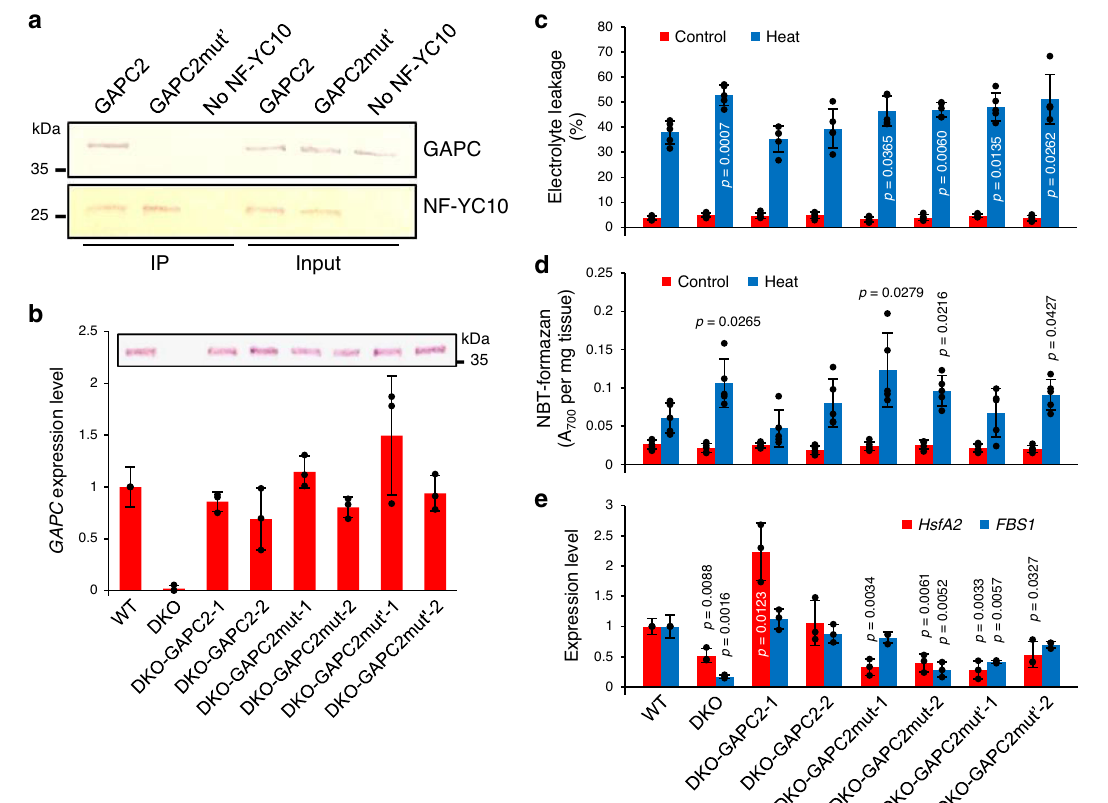
Fig. 8 Heat response of gapc1gapc2 (DKO) complemented with GAPC2 variants. a Co-immunoprecipitation of GAPC and NF-YC10. Puri fi ed GAPC2-6xHis or GAPC2mut ’ -6xHis was mixed with NF-YC10-6xHis-STREP. Immunoprecipitation (IP) was performed using an anti-STREP antibody, then immunoblotting was performed using an anti-6xHis antibody. Protein input is shown on the right. b GAPC expression levels. Total RNA was extracted from 10-day-old seedlings and quantitative RT-PCR was performed with GAPC2 -speci fi c primers. Values are average±S.D. from 3 independent seedlings and shown as fold change to WT. Black dots represent individual data points. DKO, double knockout mutant of GAPC . Inset, immunoblotting of GAPC. Total proteins were extracted from 5-day- old seedlings and GAPC was probed with the anti-GAPC antibody. c Electrolyte leakage. Conductivity was measured with true leaves from 2-week-old plants immediately after heat treatment at 40°C for 6h. Electrolyte leakage was calculated and shown here as % conductivity of total ions (boiled sample). Values are average±S.D. P values indicate signi fi cantly higher than WT determined by two-tailed student ’ s t test ( n = 5 leaves from independent plants). Black dots represent individual data points. d Reactive oxygen species production. Rosette leaves from 3-week-old plants were incubated with NBT immediately after heat treatment at 40°C for 6h. NBT-formazan was quanti fi ed as absorbance at 700nm and shown here as per tissue weight. Values are average±S.D. P values indicate signi fi cant difference from WT determined by two-tailed student ’ s t test ( n = 5 leaves from independent plants). Black dots represent individual data points. e Expression of heat-inducible genes. Total RNA was extracted from 10-day-old seedlings treated at 37°C for 5h and quantitative RT-PCR was performed with gene-speci fi c primers. Values are average±S.D. and shown as fold change to WT. P values indicate signi fi cantly lower than WT determined by two-tailed student ’ s t test ( n = 3 independent seedlings). Black dots represent individual data